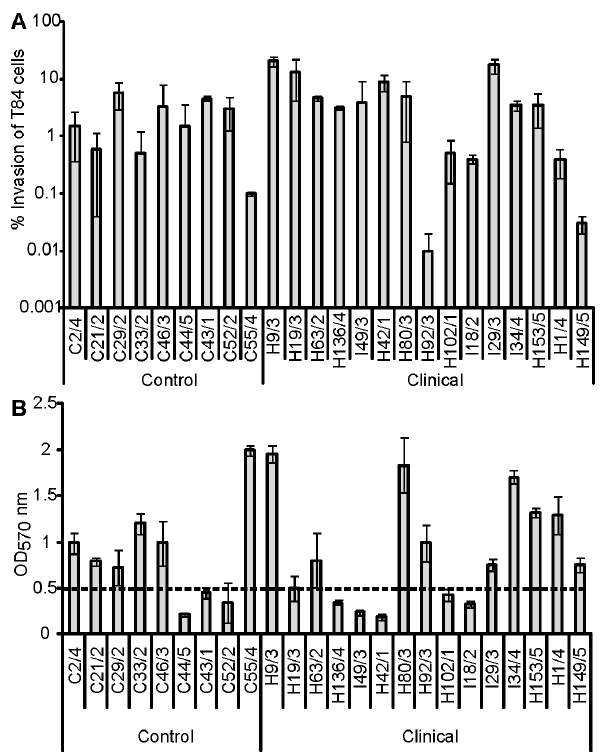
Figure 2. Phenotypic characterisation of EAEC strains. (A) Invasion levels showed by EAEC clinical and control strains after 3 h co-incubation with T84 cultured cells. No statistically significant difference between case or control strains was detected for the invasion assays. (B) Biofilm production on polystyrene determined semi- quantitatively according to OD 570 values of strains screened for biofilm production. High biofilm production was defined when OD 570 was higher/equal than